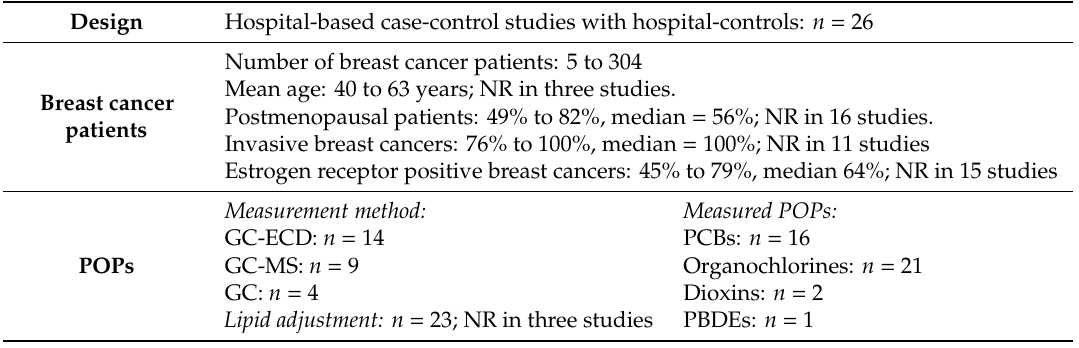
Table 2. Summary characteristics of studies of breast adipose tissue POPs and breast cancer risk ( n = 26).